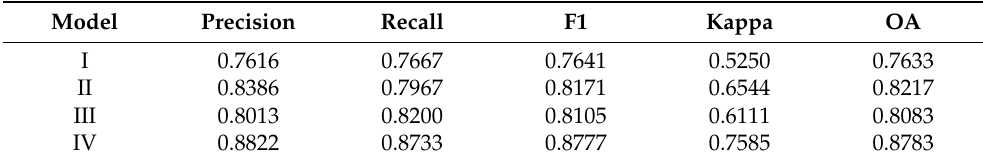
Table 5. Comparison of the accuracies of the models with different module combinations in test area C.